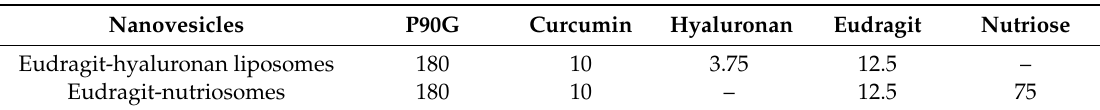
Table 1. Composition (expressed as mg/mL of water in rehydrated samples) of Eudragit-hyaluronan liposomes and Eudragit-nutriosomes. Nanovesicles P90G Eudragit-hyaluronan liposomes